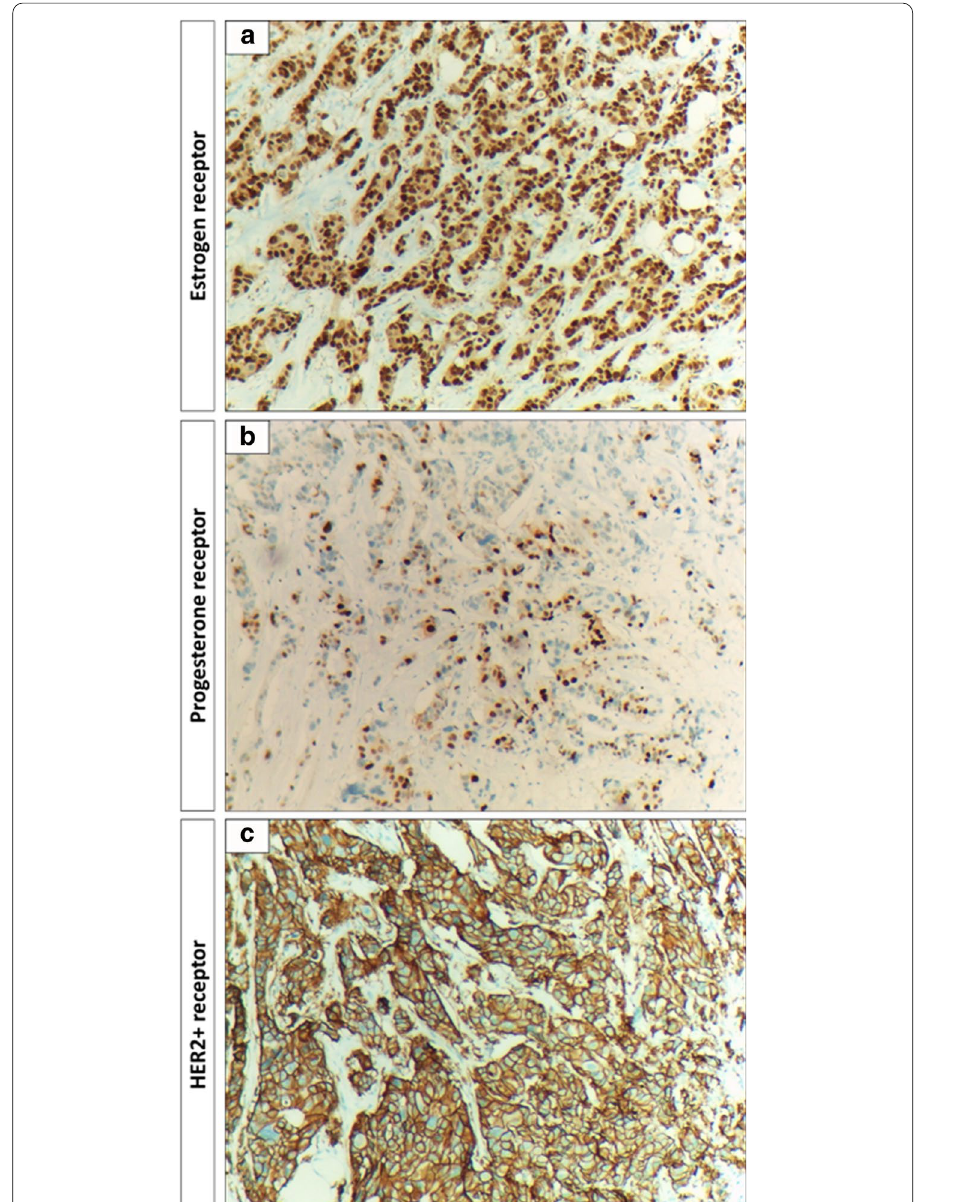
Fig. 3 Immunohistochemical analysis of breast cancer samples. a Infiltrating lobular carcinoma at 10 × magnification power showing that tumor cells are markedly positive for estrogen hormonal nuclear receptors in about 85% of tumor cells, score 3 5/8. b Infiltrating lobular carcinoma of the breast at 10 magnification + × power showing that tumor cells are moderately positive for progesterone hormonal nuclear receptors in about 35% of tumor cells, score 2 4/8. c Infiltrating duct carcinoma at 10 magnification power showing + × that tumor cells are markedly positive staining with continuous and intense membranous staining for Her2 + protein, over-expression score +